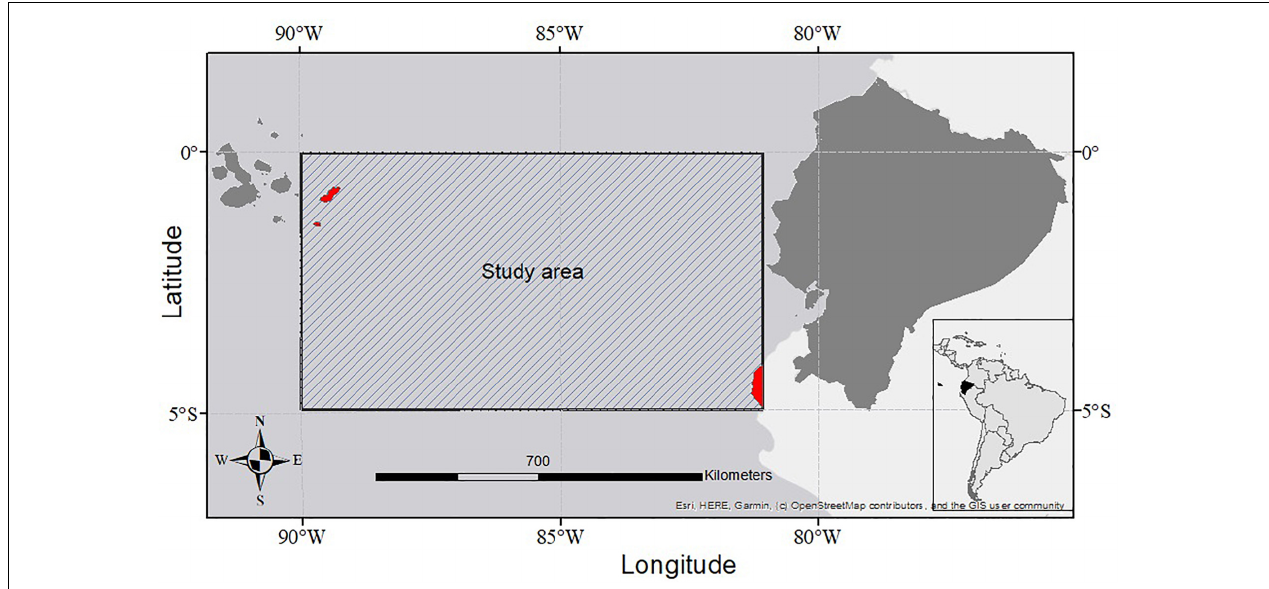
FIGURE 1 | Study area over the eastern equatorial Pacific, called Niño E (Takahashi and Dewitte, 2016). The zones over land (red) are excluded from the study